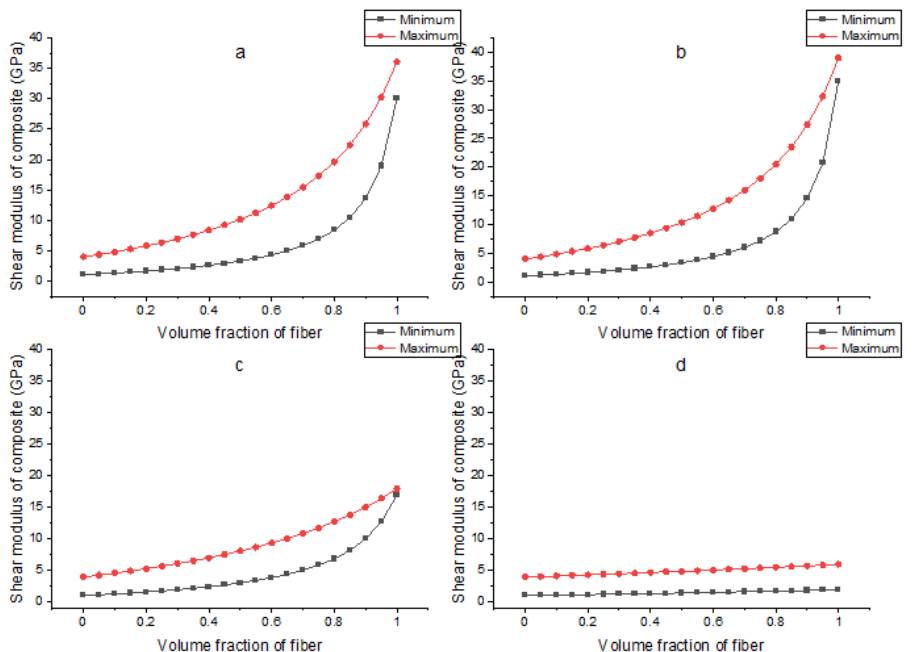
Figure A3. Depicts the variation in shear modulus of ( a ) E-glass, ( b ) S-glass, ( c ) T300 carbon fiber and ( d ) AS carbon with volume of fiber. It can be seen that as the fiber ratio increases, the shear modulus of the all the materials increases. The graph follows a similar trend for ( a – c ); however, for ( d ) the material varies linearly with less variation with the fiber ratio.